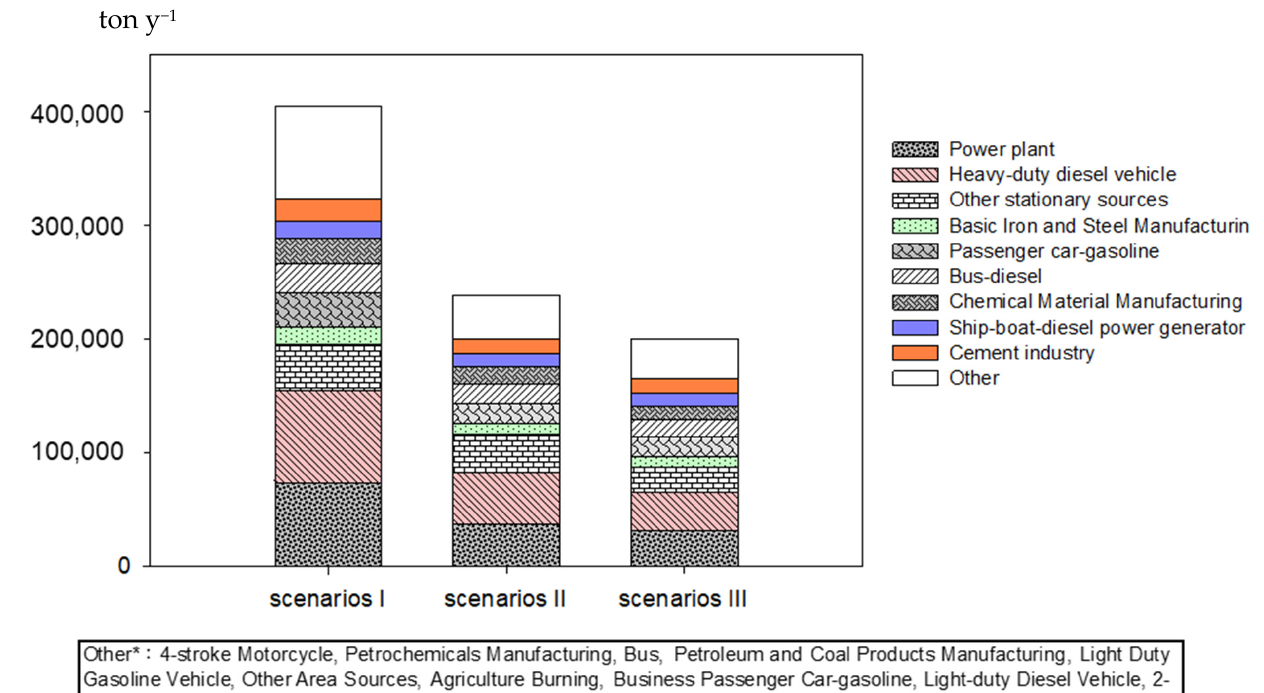
Figure 3. SO 2 emission sources for different scenarios (ton y − 1 ).